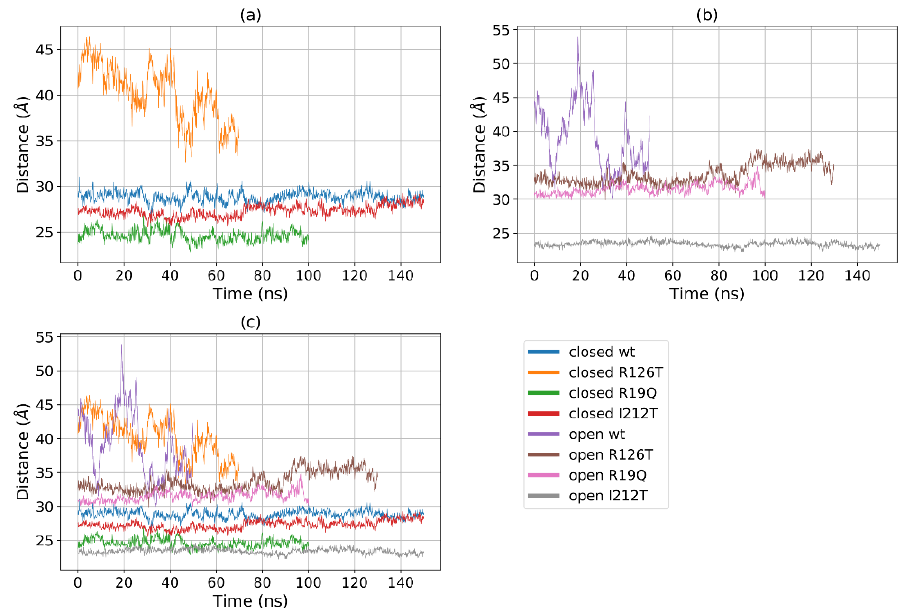
Figure 6. Distances between the centers of mass of domains I and III for ( a ) all the investigated systems, ( b ) closed systems and ( c ) open systems.